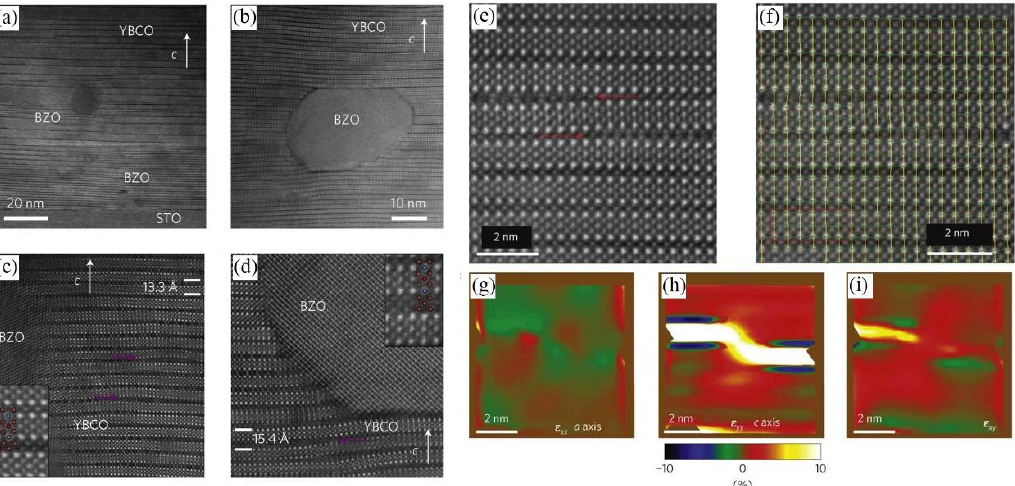
Figure 10. Z-contrast images of BZO nanoparticles in YBCO matrix at low ( a ) and high ( b ) magnification. ( c – d ) High−resolution Z−contrast images present the region between two different BZO nanoparticles. The insets in ( c – d ) show intergrowth in detail. ( e ) Z−contrast image where the strain maps were generated. ( f ) Grid obtained by Peak Pairs Analysis (PPA) from ( e ). ( g – i ) ɛ xx , ɛ yy and ɛ xy maps, respectively. Reprinted with permission from Ref. [86] . Copyright 2012, Nature Portfolio.